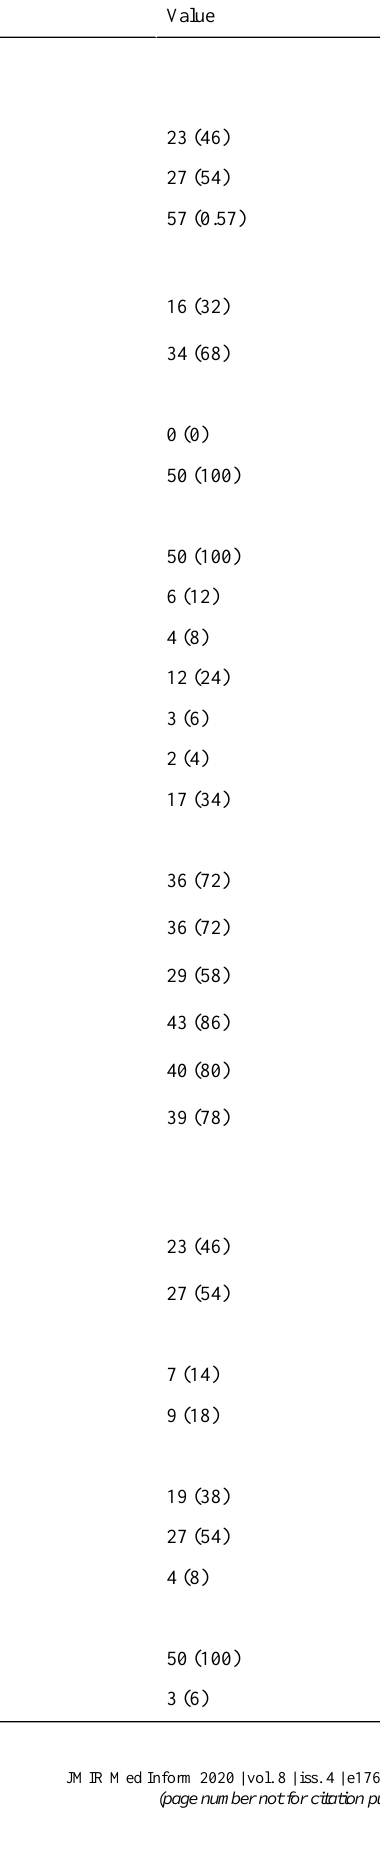
Table 2. Patient characteristics from the collected data